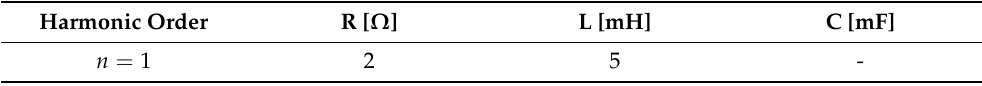
Table 1. List of values of resistance and inductance. Harmonic